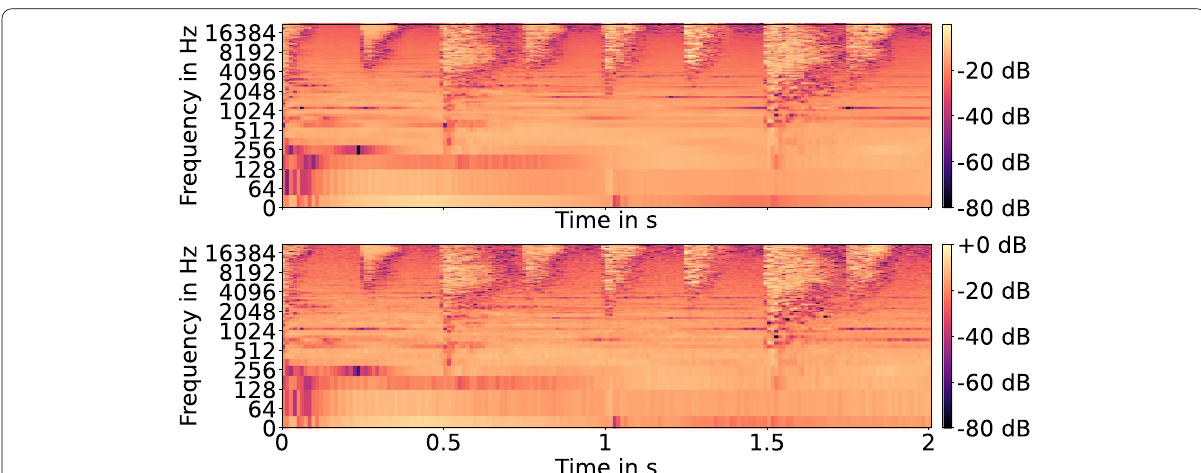
Fig. 4 Spectrogram of an audio sample at 0 dB mixing volume using distortion with gain set to 0.15 and tone set to 0.8 after normalization of the dataset as explained in Section 2.2 without (top) additional noise, i.e., α = 0 , and with (bottom) additional noise with α = 0.001 and α as explained in Section 2.3.2. The noise is noticeable mostly at low